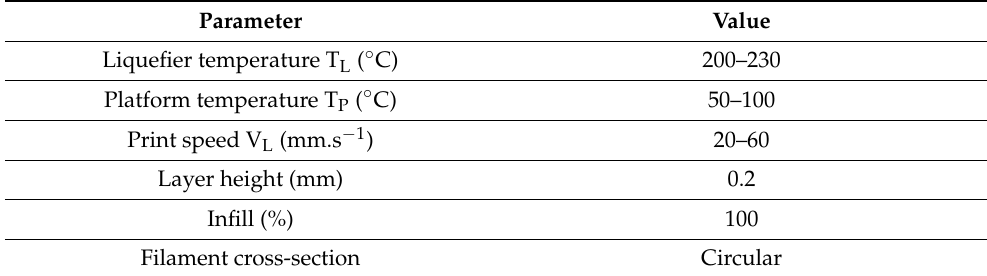
Table 1. Process variables of the 3D-printing